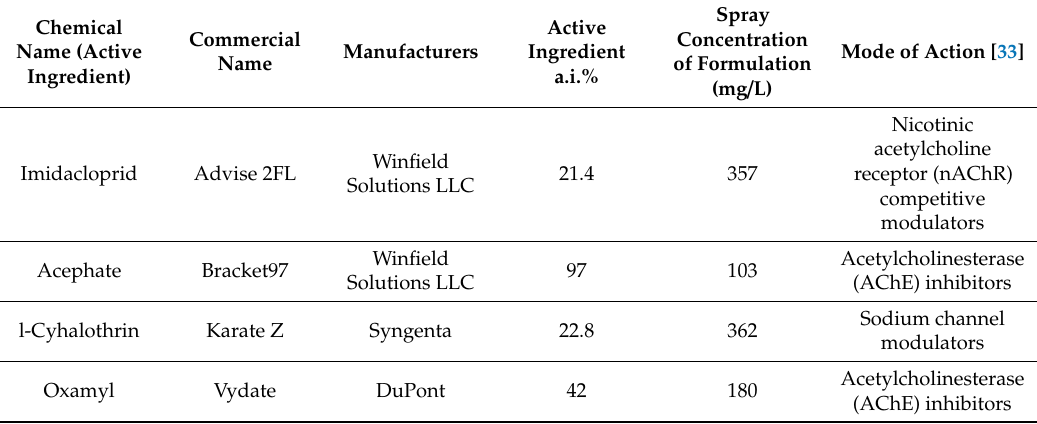
Table 1. Pesticide name, manufacturer, percentage of active ingredient, spray concentration of formulation, and mode of